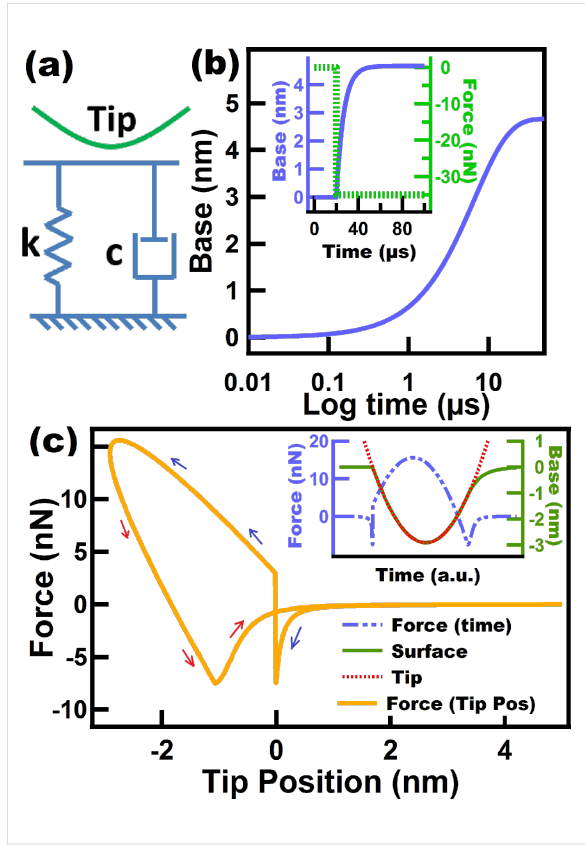
Figure 2: (a) Linear Kelvin–Voigt model scheme; (b) creep simulation performed on a Linear Kelvin–Voigt surface, whereby a force of − 35 nN is applied at time zero. The horizontal axis is plotted using a logarithmic scale to show the inflection point corresponding to the single retardation time of the model. The inset shows the same experi- ment but here the force is applied at time t = 20 µs and the surface creeps. (c) Force–distance tip trajectory corresponding to a tapping tip over a Linear Kelvin–Voigt sample. The inset shows the base (surface) and tip position, and the force along one fundamental oscillation. The tip was oscillated along a numerically simulated trajectory (not prescribed) for tapping mode AFM. The parameters used for (c) are: cantilever position z c = 80 nm, natural frequency ( f 0 ) = 75 kHz, free amplitude ( A 01 ) = 100 nm, cantilever stiffness ( k m1 ) = 4 N/m. The Linear Kelvin–Voigt parameters used for (b) and (c) were k = 7.5 N/m and c = 1.0 × 10 − 6 N·s/m. The blue and red arrows in (c) correspond to approach and retraction of the tip,